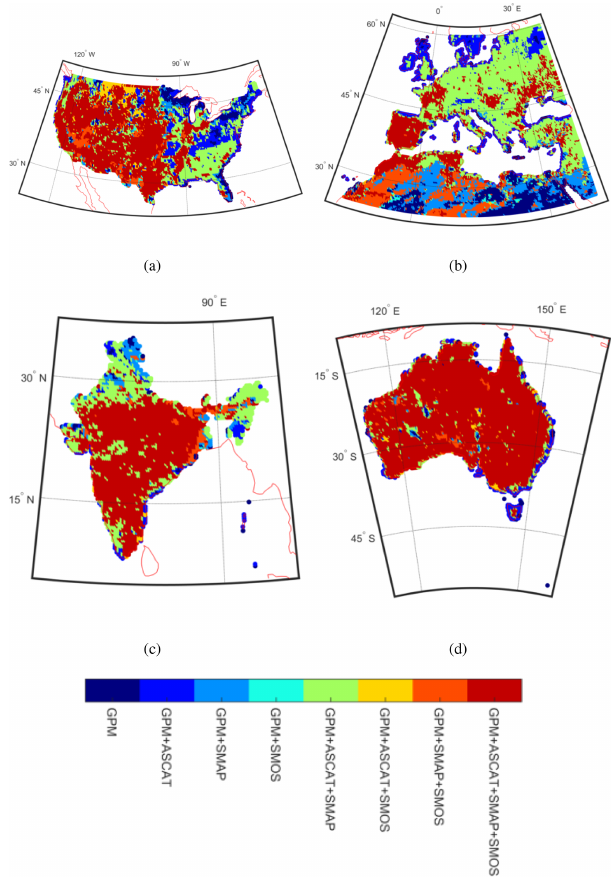
Figure 3. Products used in the integration over CONUS (a) , Eu- rope (b) , India (c) and Australia (d) . The results refer to 2015–2017